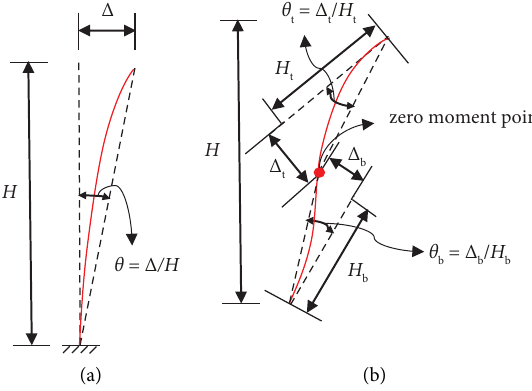
Figure 12: Schematic diagram of component drift ratio. (a) Cantilever. (b) Structural